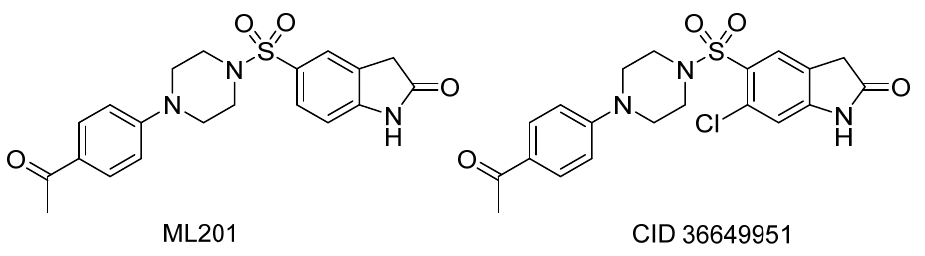
Figure 6. ML201 and its derivative CID36649951.